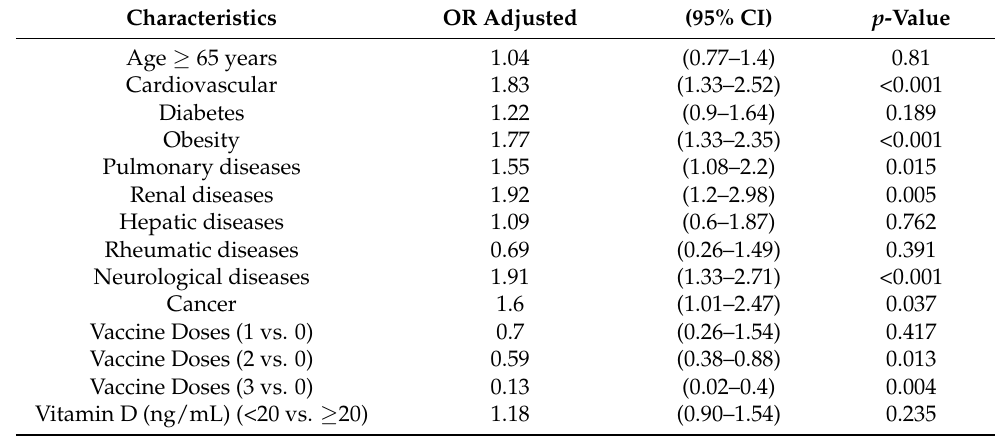
Table 4. Multivariate logistic regression with dependent variable evolution to intensive care needs, adjusted for 25(OH)D status and all other